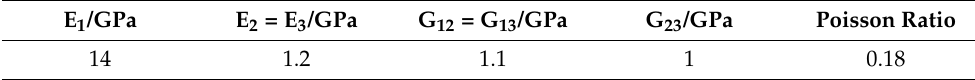
Table 3. Engineering elastic constants of the GFRP combined with